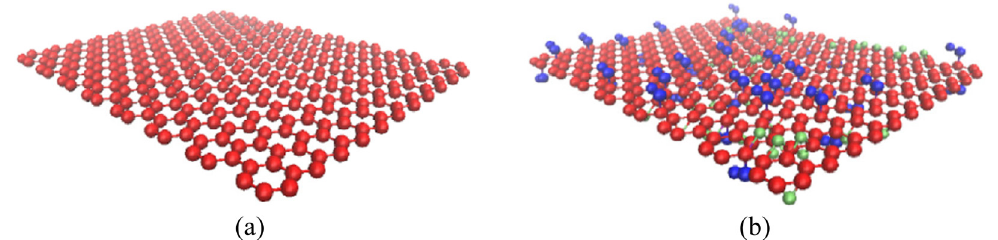
Figure 1: The microstructure of GP and GO [ 47 ] : ( a ) GP and ( b )